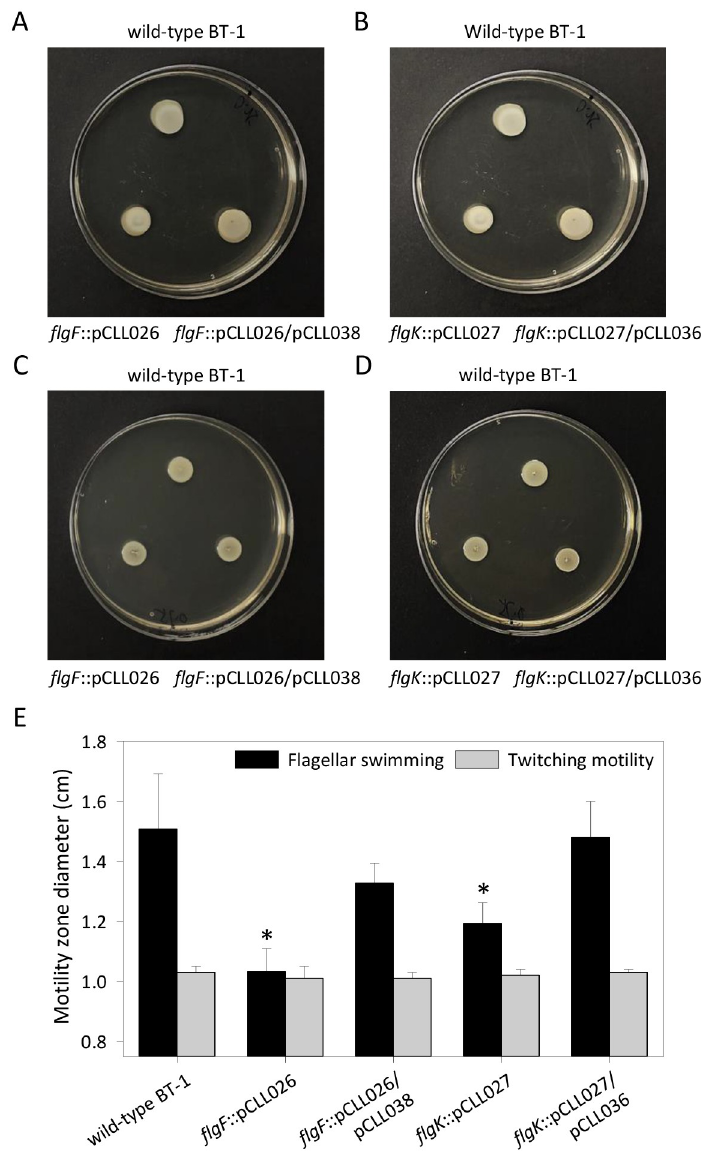
Fig 2. Mutations in the L . crescens BT-1 flagellar genes flgF and flgK affected only swimming motility. (A, B) Swimming and (C, D) twitching motility in the wild-type BT-1, insertional flagellar gene mutants ( flgF ::pCLL026 and flgK ::pCLL027) and complemented ( flgF ::pCLL026/pCLL038 and flgK ::pCLL027/pCLL036) strains on semisolid BM7A plates containing 0.25% and 0.75% agar for swimming and twitching assays, respectively. (E) Swimming and twitching motility zone diameters were measured in three independent assays with three replicates each. The data are average ± standard deviation and the significant differences ( P < 0.05, Student’s t test) in swimming behavior are represented by asterisks